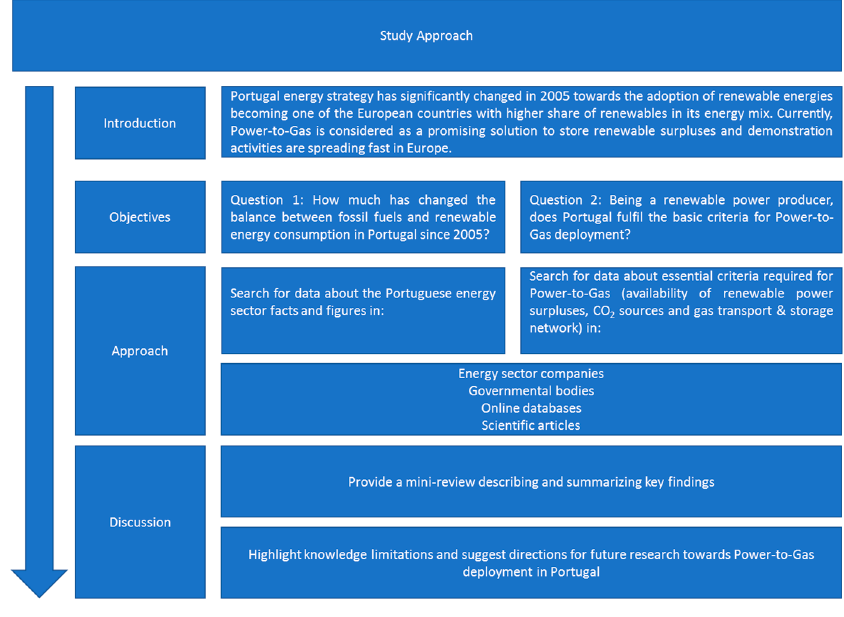
Figure 2. Diagram presenting the study approach adopted in this work.